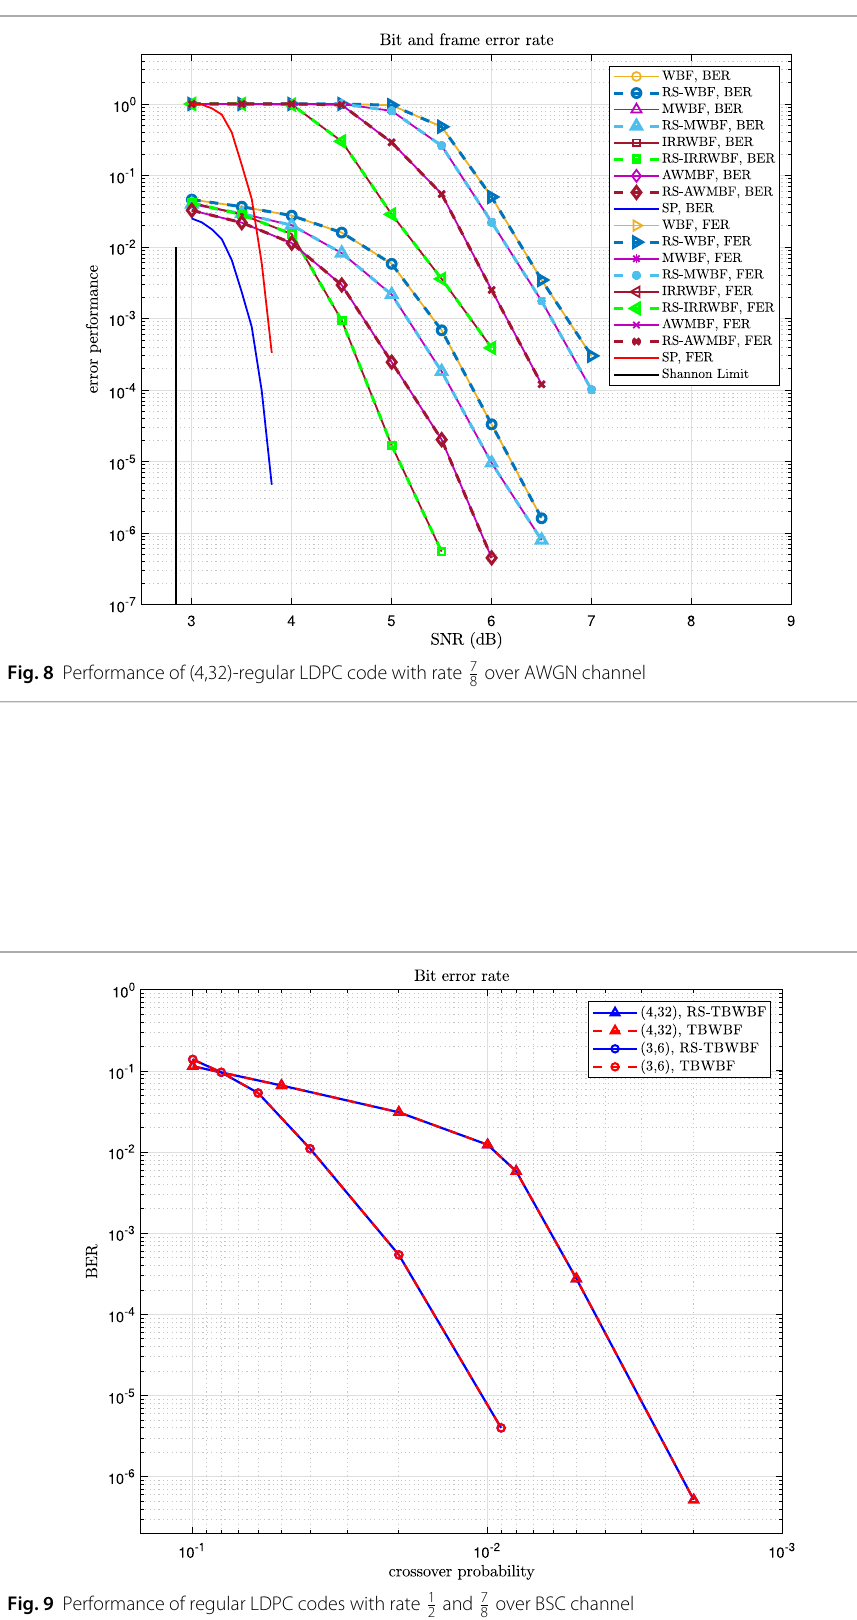
and 7 over BSC 2 8